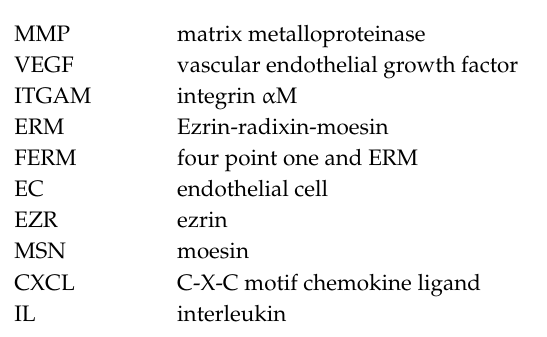
Supplementary Materials: Supplementary material Figure S1 and Table S1 can be found at http: // www.mdpi. com / 1422-0067 / 21 / 20 / 7716 /